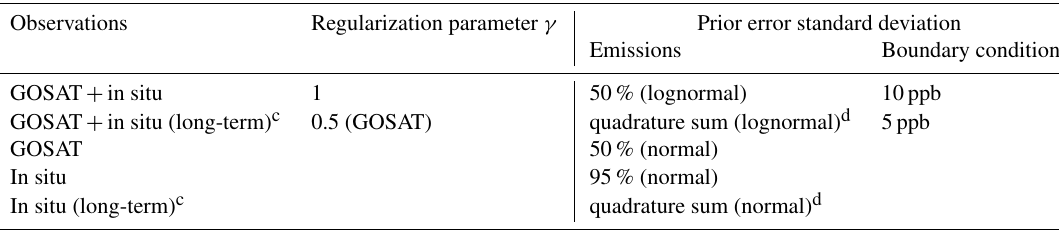
Table 2. Settings for generation of the 33-member inversion ensemble a .